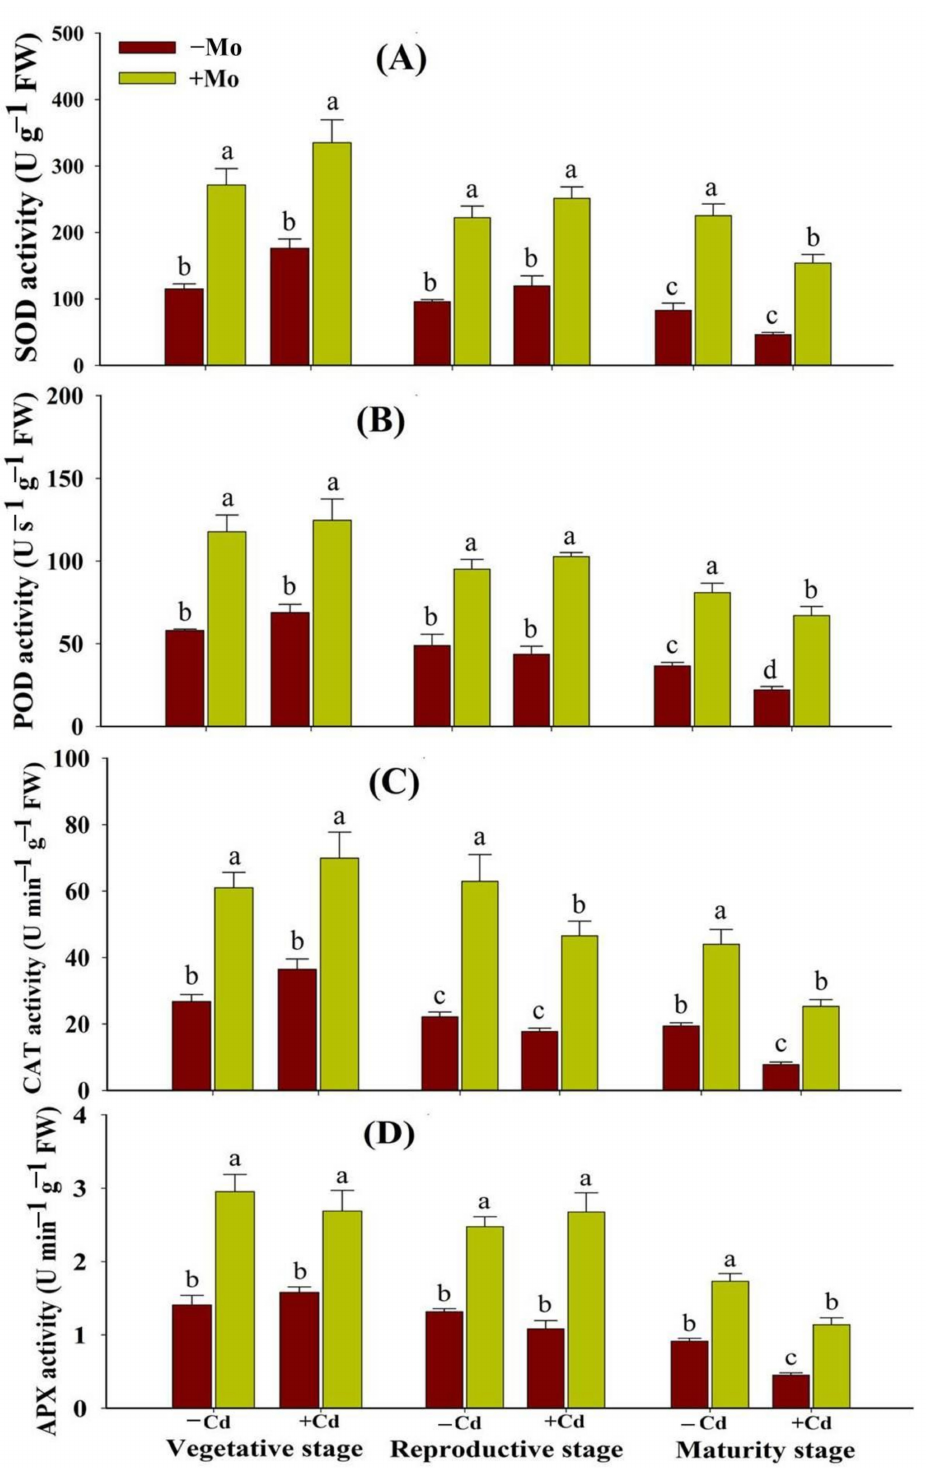
Figure 5. Effect of Mo supply and Cd toxicity on the activities of enzymatic antioxidants: superoxide dismutase (SOD) ( A ); peroxidase (POD) ( B ); catalase (CAT) ( C ); and ascorbate peroxidase (APX) ( D ), in the leaves of aromatic rice ‘Xiangyaxi- angzhan’ cultivar, at the vegetative, reproductive, and maturity stages. Bars above means indicate ± S.E. of four independent replicates ( n = 4) and different small alphabetical letters above means reveal significant differences among treatments within a particular growth stage according to the LSD test ( p <